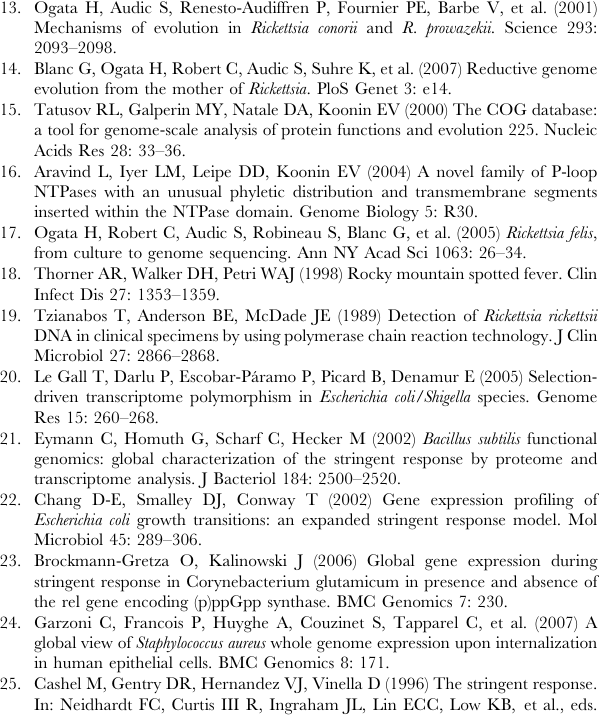
Table S2 R. conorii genes down-regulated within